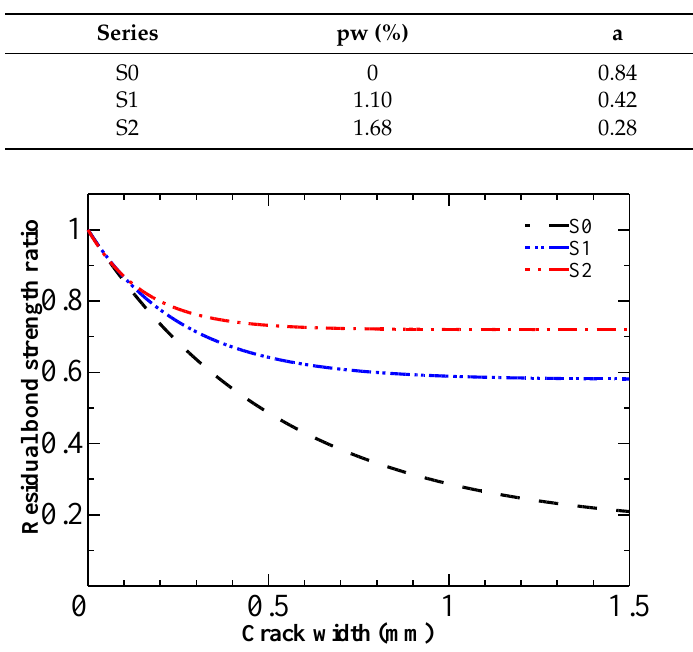
Figure 13. Residual bond strength ratio versus crack width : ( a ) series S0; ( b ) series S1; ( c ) series S2. Table 3. Regression analysis result. Table 3. Regression analysis result.